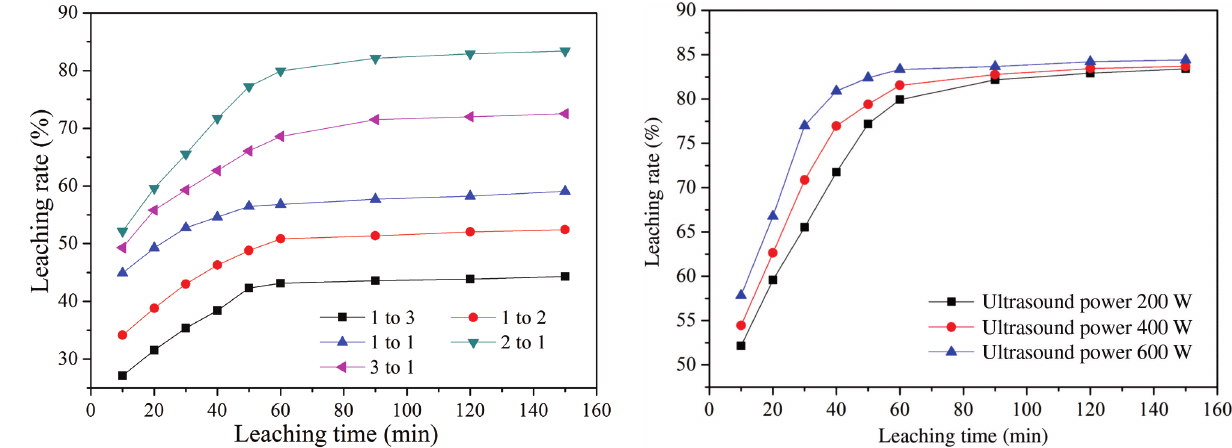
Figure 5: The effects of ultrasound power on zinc leaching and C on zinc NH 3 (NH 4 ) 2 SO 4